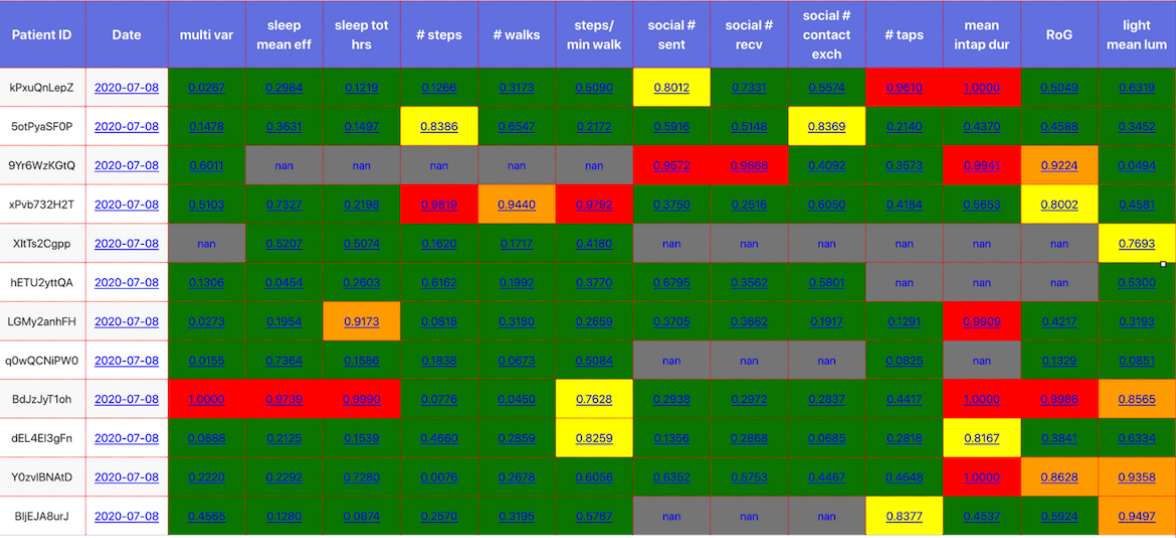
Figure 5. The anomaly detection dashboard with a visualization of the scores from a collection of anomaly detection